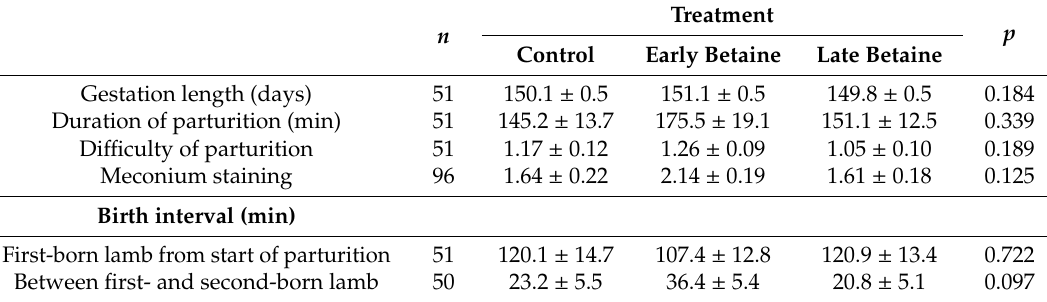
Table 2. Gestation length, duration and di ffi culty of parturition, birth interval and lamb meconium staining. Data are least-squares mean ±